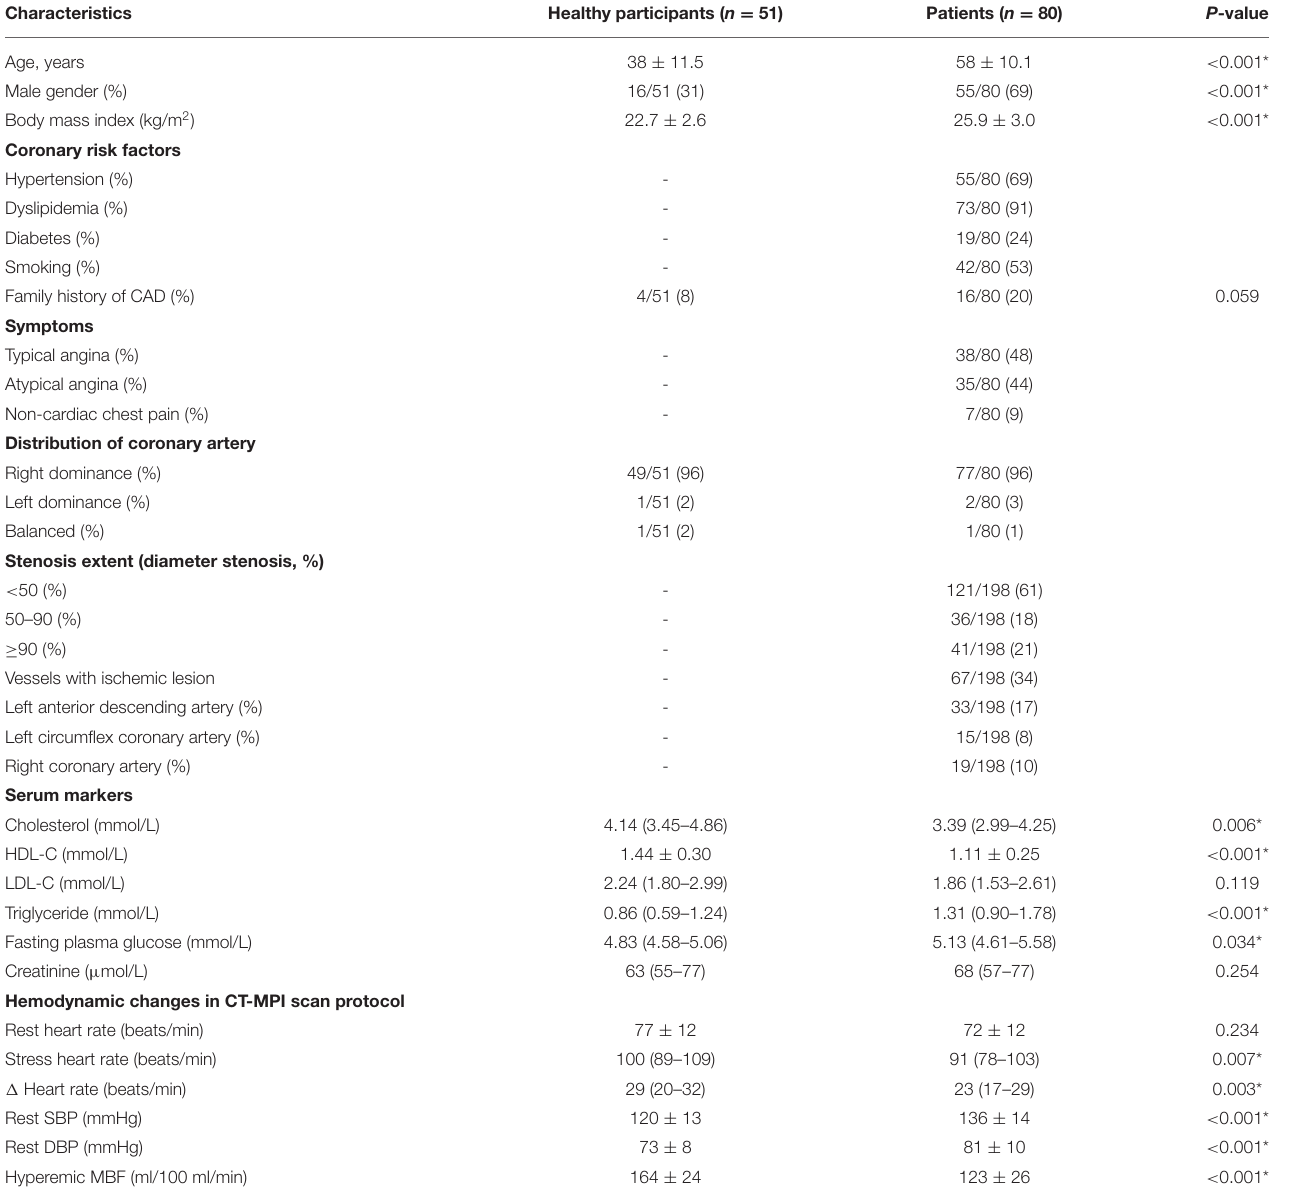
TABLE 1 | The demographic, clinical and imaging characteristics of healthy participants and patients.